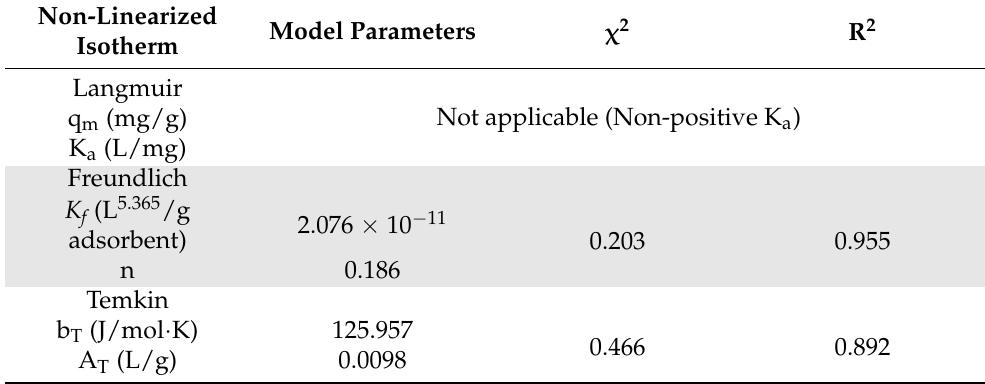
Table 4. The Chi-square statistic, χ 2 , R 2 , and isotherm models